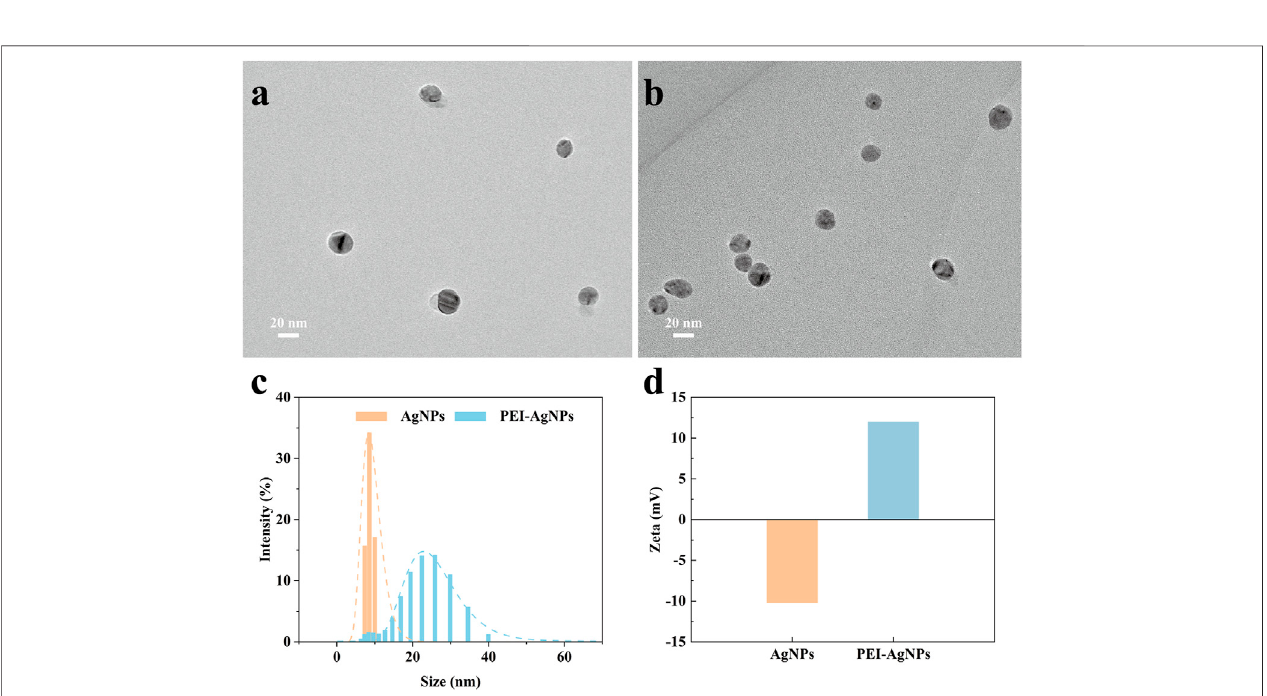
Frontiers in Bioengineering and Biotechnology |